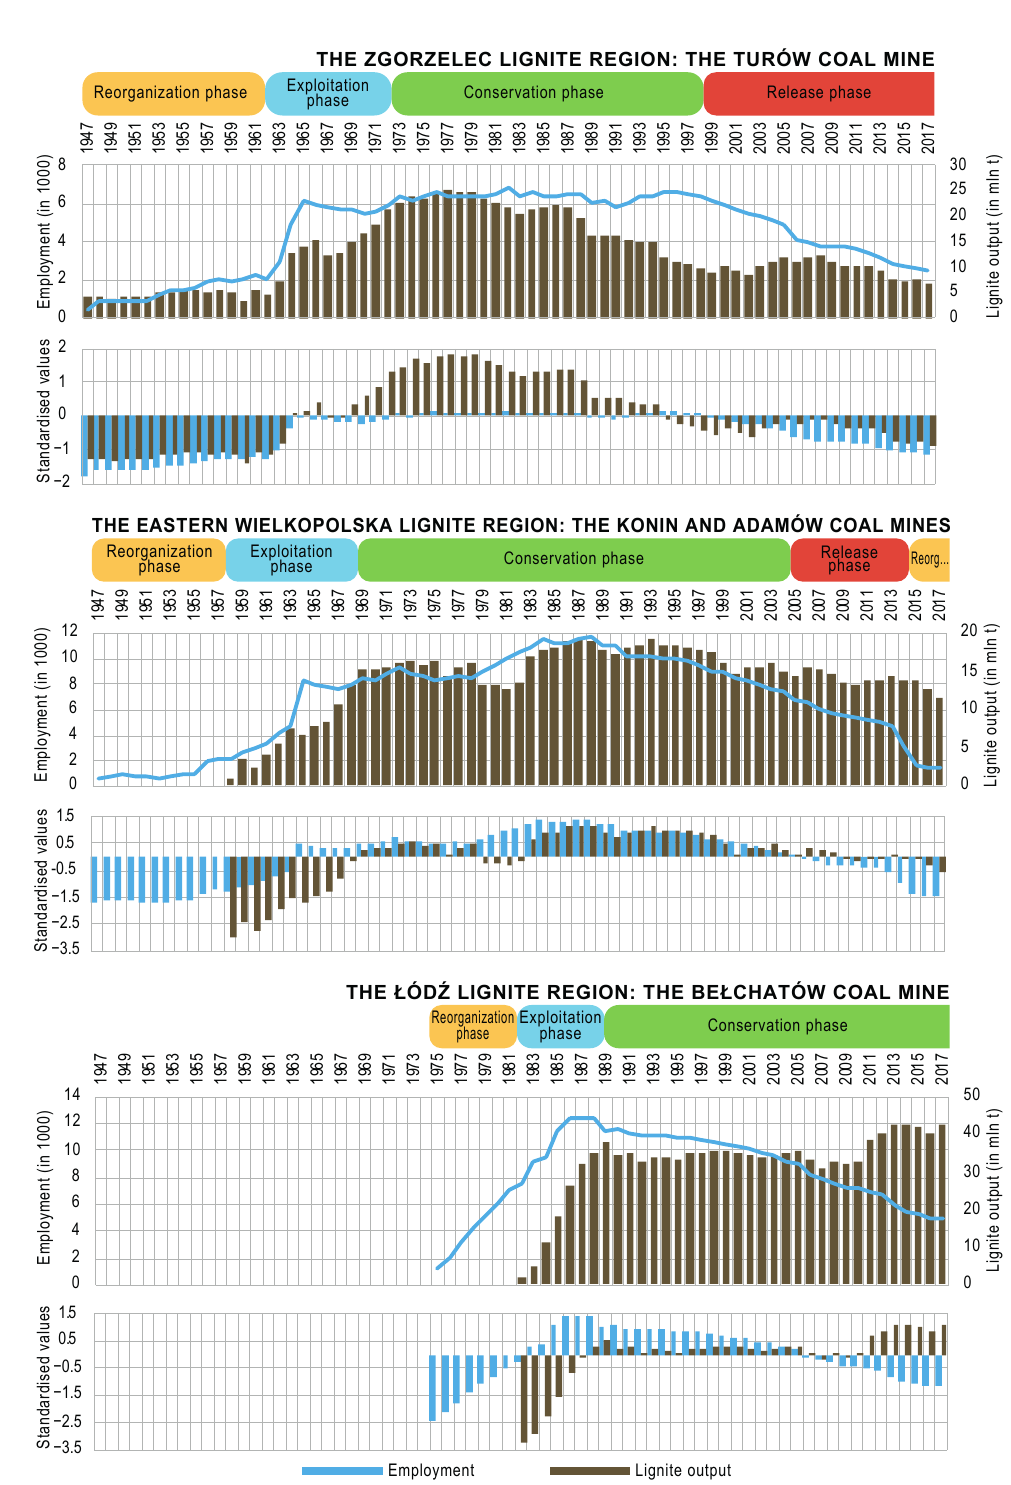
Figure 3. Adaptive cycles of Polish lignite regions in relation to employment and coal extraction in mines in the period between 1947 and 2017. (The colours indicate phases of the adaptive cycle: reorganization—orange; exploitation—blue; conservation—green;